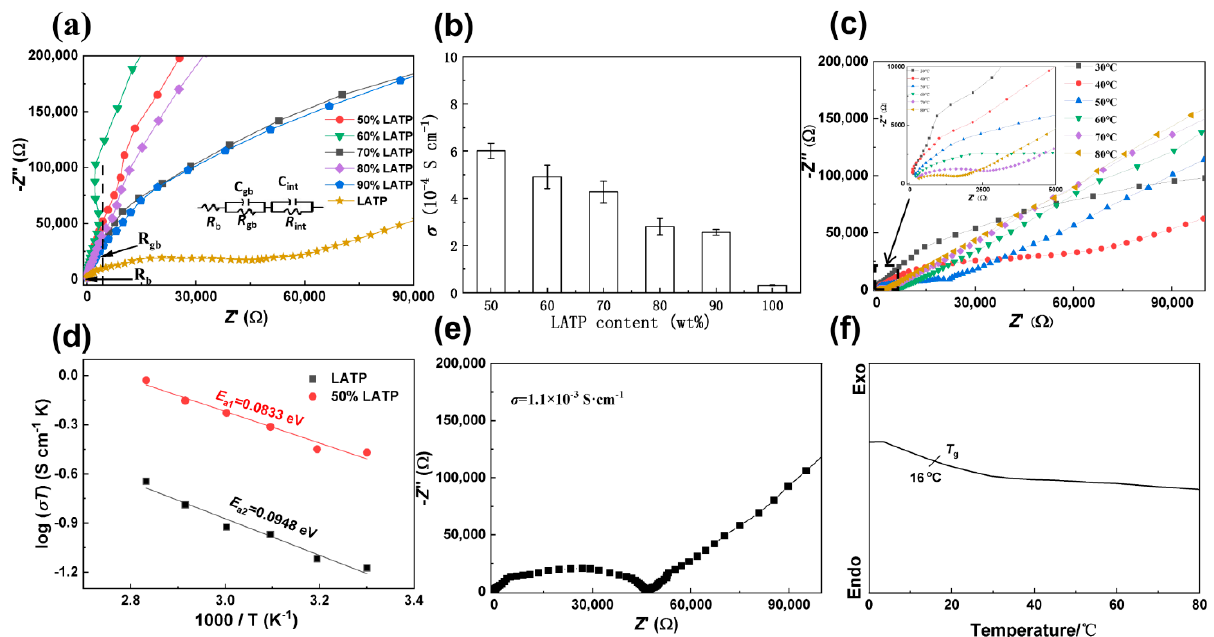
Figure 4. EIS curves ( a ) (inset equivalent circuit, R b : bulk resistance, R gb : grain boundary resistance,